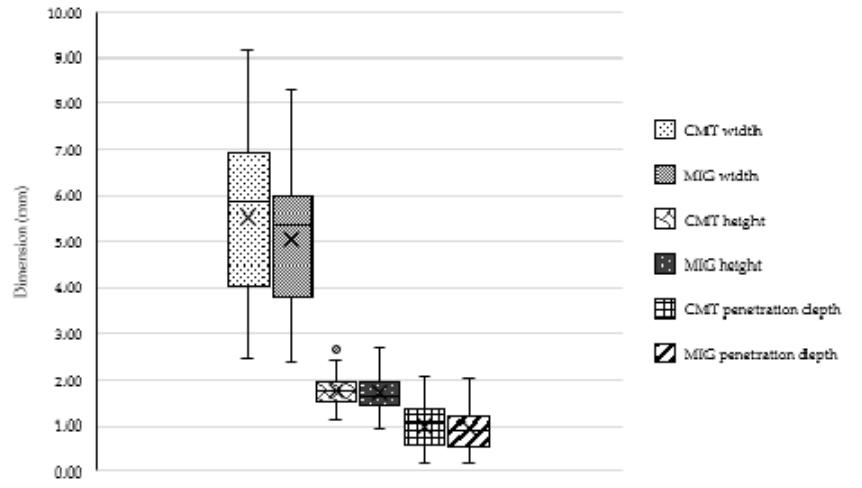
Figure 8. Distribution of specimen dimensions for CMT and MIG comparison across all parameter sets.